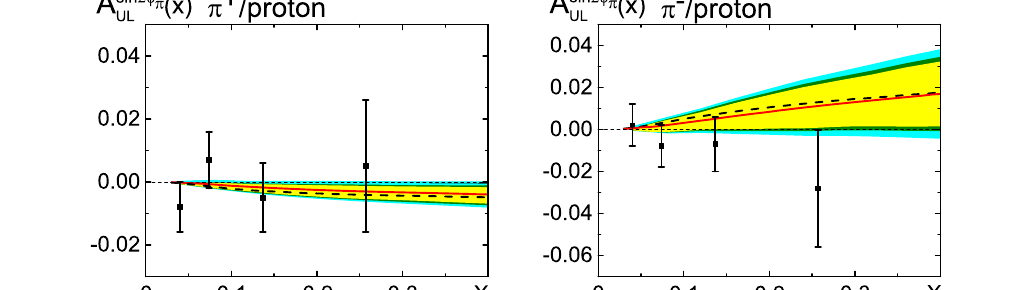
sign for them. Also, the evolution effect from lower scale to higher scale drives the peak of the distribution to the smaller x region.